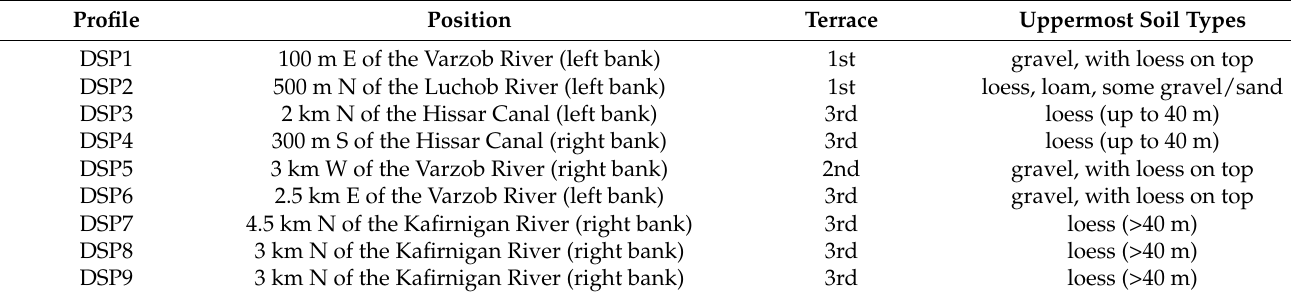
Table 2. Seismic refraction tomography (SRT) profiles with details on location, position relative to the three terraces and prevalent soil types visible from the